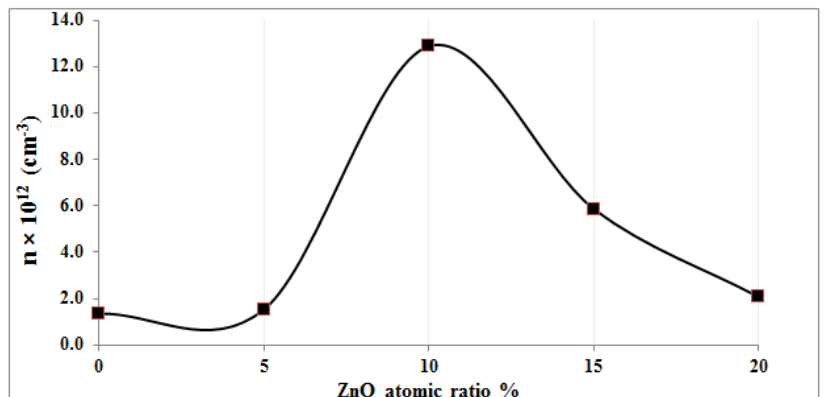
Fig.4: Variation in charge carrier density with ZnO atomic ratio.